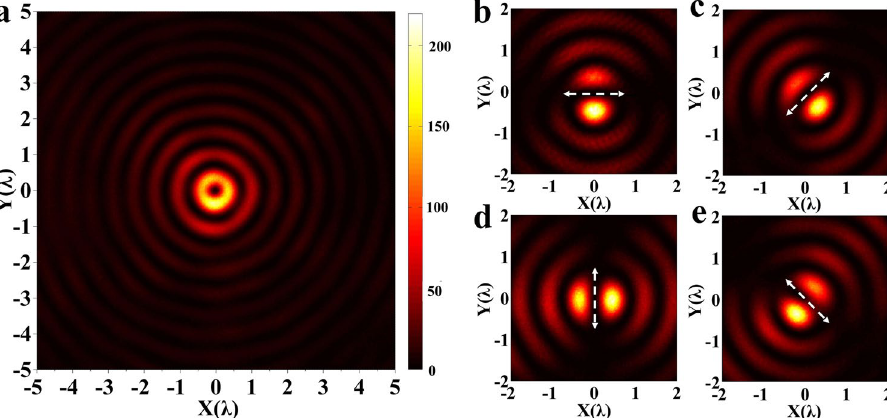
Figure 6. Experimental characterization of the polarization of the optical hollow needle. ( a ) the color map of the in-plane optical intensity on the XY plane at z = 307 λ ; ( b ) – ( e ) the in-plane optical intensity distributions at z = 307 λ when linear polarizer P2 (as shown in Fig. 5) is inserted in the optical path in different orientations of 0 deg, 45 deg, 90 deg, and 135 deg, respectively, where the arrows denote the directions of the polarizer. All optical intensity distributions are given in arbitrary unit.